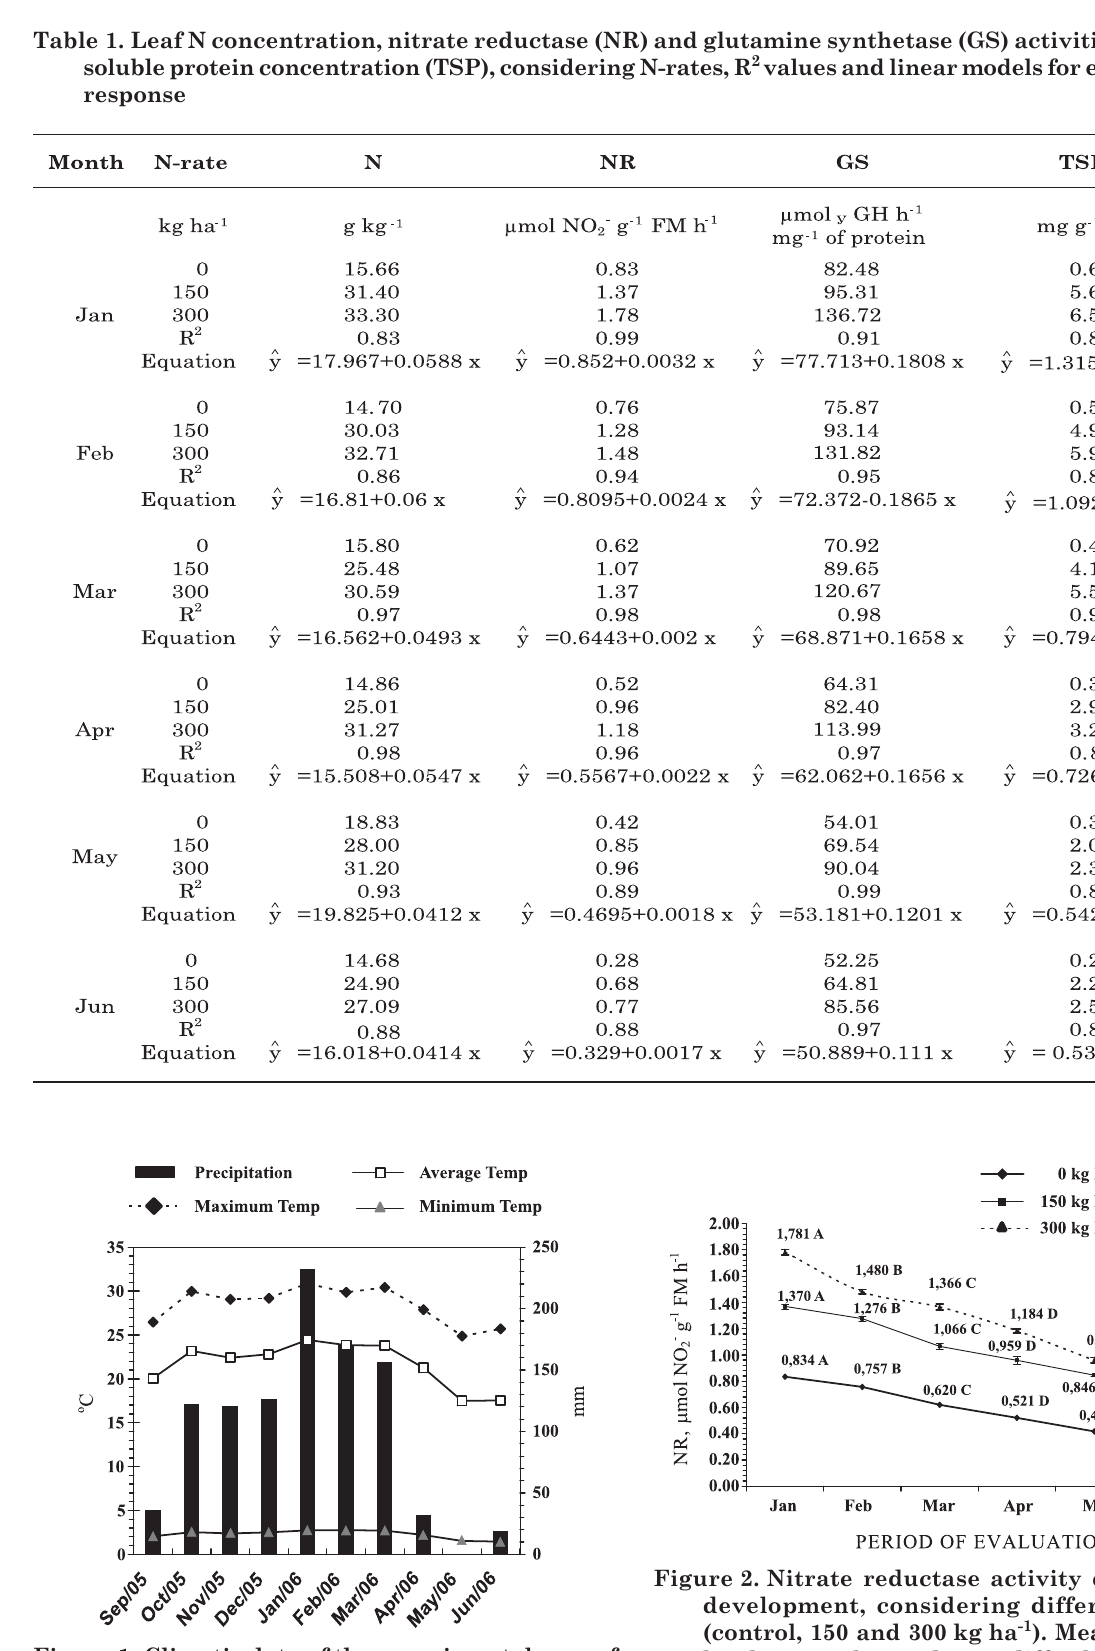
Figure 1. Climatic data of the experimental area of “Areão ” Farm, in Piracicaba, State of São Paulo.